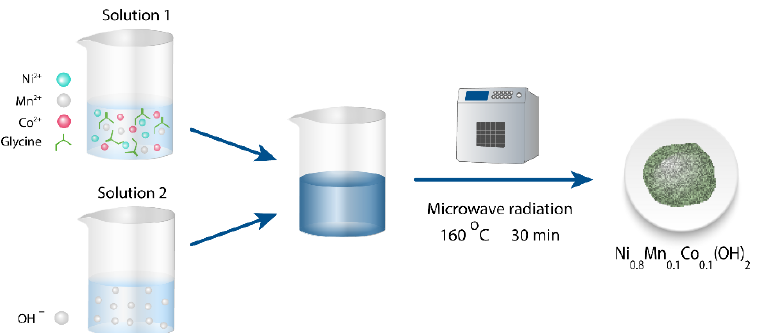
Figure 1. Scheme of the mixed hydroxide precursor Ni 0.8 Mn 0.1 Co 0.1 (OH) 2 synthesis via a microwave- assisted hydrothermal route.